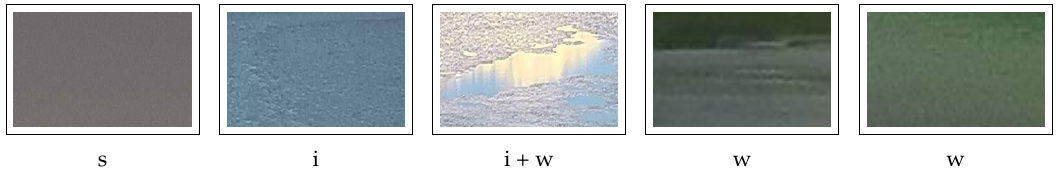
Figure 8. Inter-class similarities and intra-class differences of states snow (s), ice (i), and water (w) in our webcam